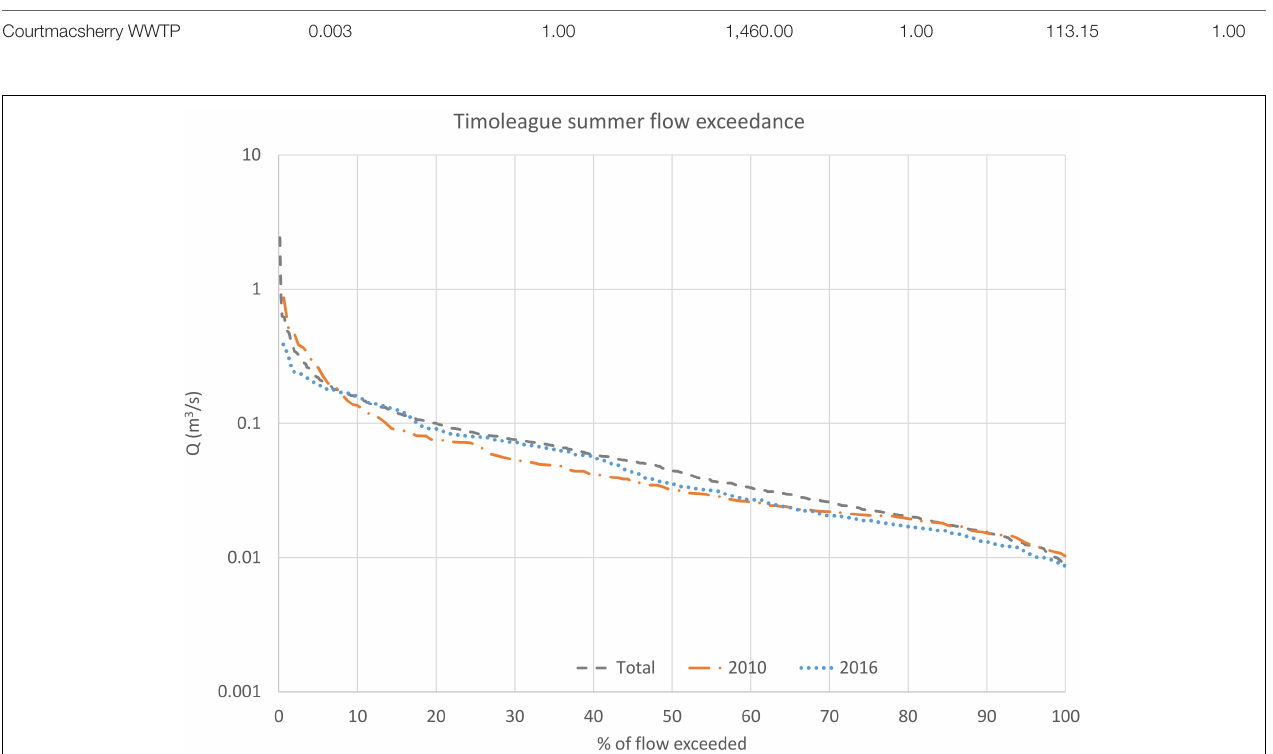
FIGURE 4 | Comparison of the summer flow exceedance distributions for 2010 and 2016 versus the overall summer flow exceedance distribution for 2010-2016.